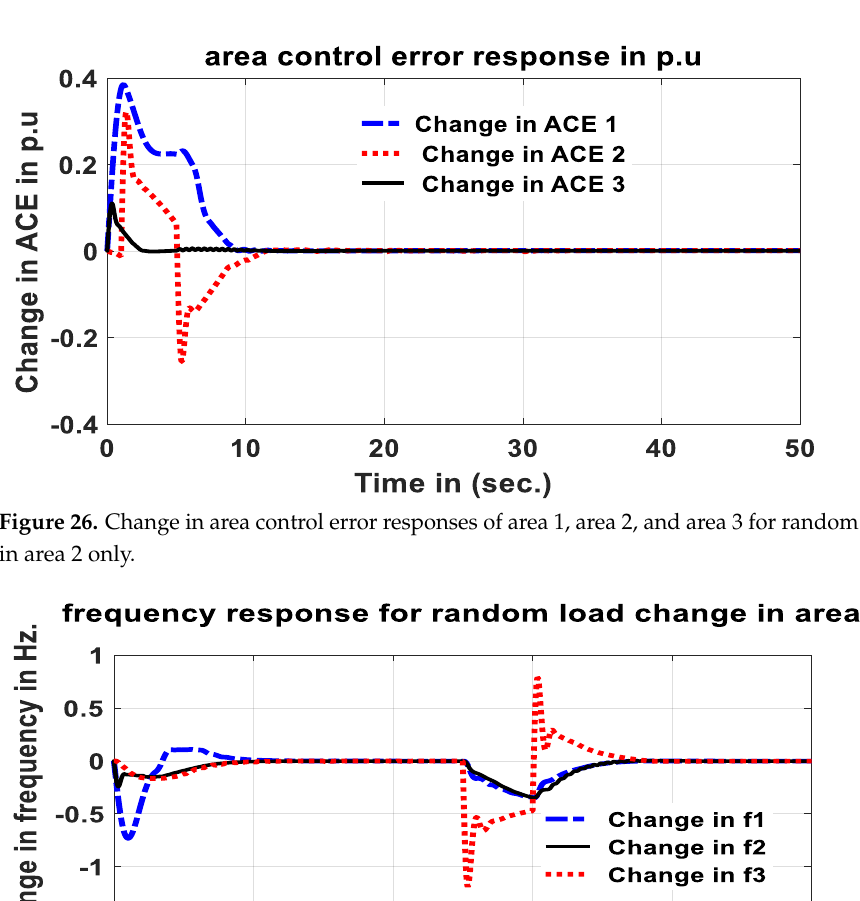
Figure 25. Change in tie-line power responses of area 1,area 2, and area 3 for random load change in area 2 only.